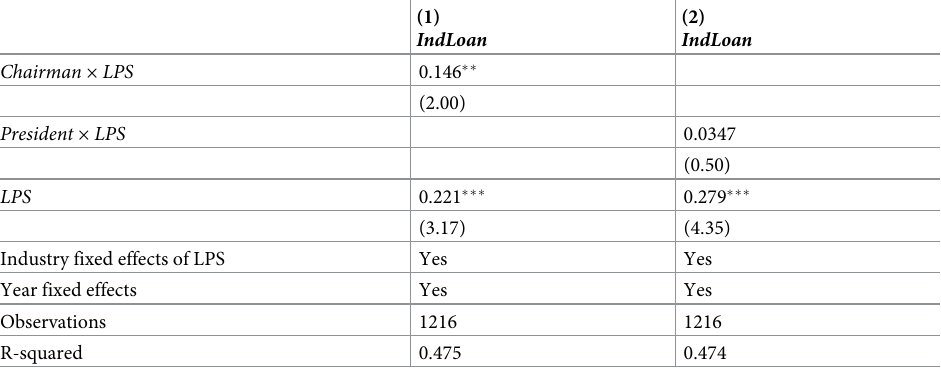
Table 10. How the largest private shareholders influence bank’s loan: Manager or board. This table reports the esti- mation results from OLS regressions analyzing the impact of the largest private shareholder on bank lending to their industry, with a different interaction terms for each column. Columns 1–2 uses IndLoan as the dependent variable. Variables are defined in S1 Appendix. The sample period is from 2007 to 2020. In parentheses are t-statistics. ��� , �� , � indicate statistical significance at the 1%, 5%, and 10% level, respectively.